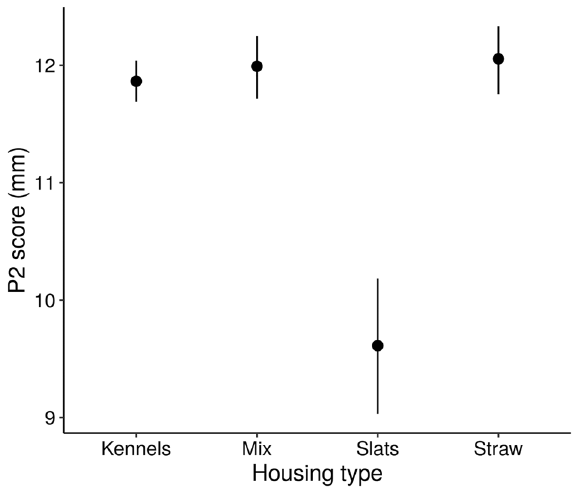
Figure 6. The effect of pig housing type on P2 score (a measure of back fat). Circles denote the mean posterior estimates and vertical line segments show their 95% highest density intervals. Kennels = kennelled housing; Mix = mixed housing (combinations of different housing types farm); Straw = straw yards and slats = slatted flooring.